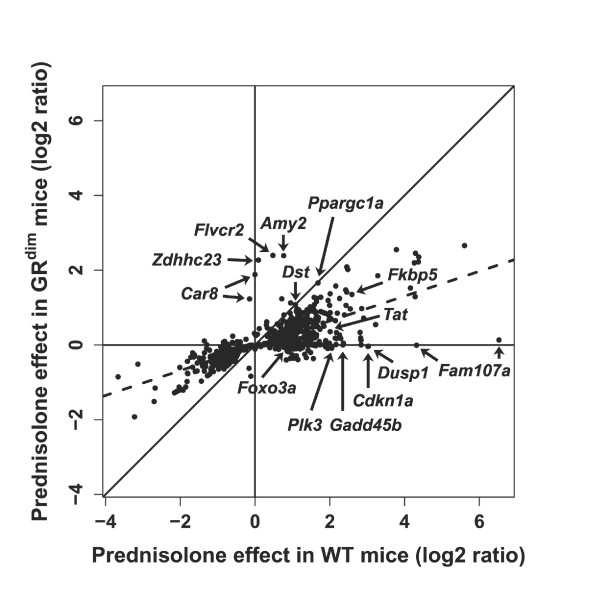
Log2 ratio plot of prednisolone-induced differential gene expression in wild type versus GRdim mice. Genes on the solid black line show an equal induction of differential gene expression by prednisolone in wild type (WT) versus GRdim mice. The black-dotted line indicates the average slope of the data and shows that the level of gene regulation in prednisolone-treated GRdim mice is 33% of that observed in WT mice. A subset of genes that show obvious differences in the magnitude of regulation by prednisolone in WT versus GRdim mice is highlighted, as well as genes that show equal magnitude of regulation in WT versus GRdim mice.